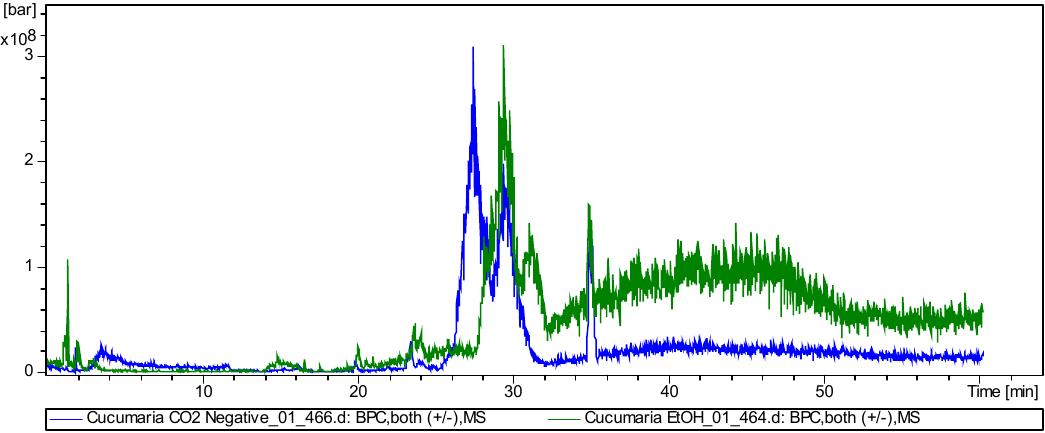
Figure 3. Liquid chromatography–electrospray mass spectrometry (LC-ESI MS) total compounds chromatogram of detected triterpene glycosides in negative ion mode (sulfated, disulfated and non-sulfated glycosides were detected as [M − Na] − , [M − 2Na] 2 − and [M − H] − ions) in supercritical extract of C. frondosa japonica .